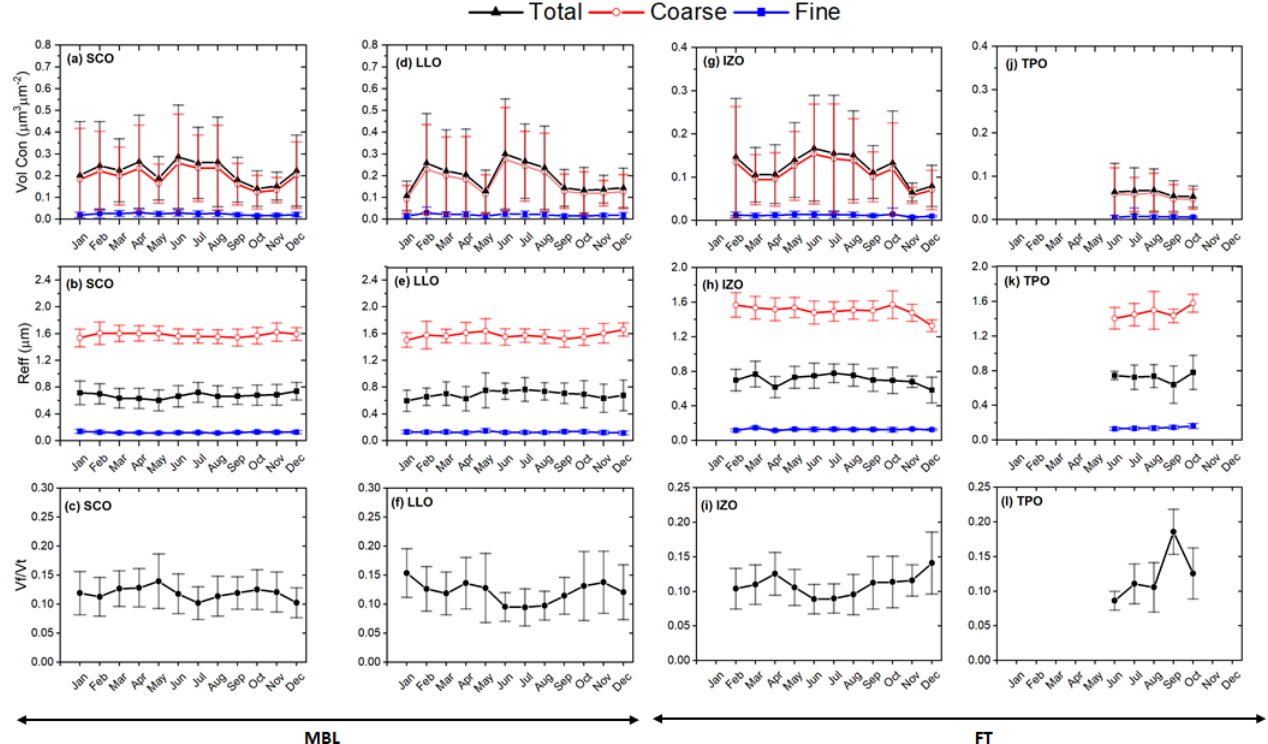
Figure 8. Monthly mean volume particle concentration (VolCon; µm 3 µm − 2 ) and effective radius ( R eff ; µm) of the total (black), coarse (red) and fine (blue) modes and the fine-mode volume fractions ( V f /V t ) at (a, b, c, d) SCO, (e, f, g, h) LLO, (i, j, k, l) IZO and (m, n, o, p) TPO under dust-laden conditions. The error bars indicate the standard